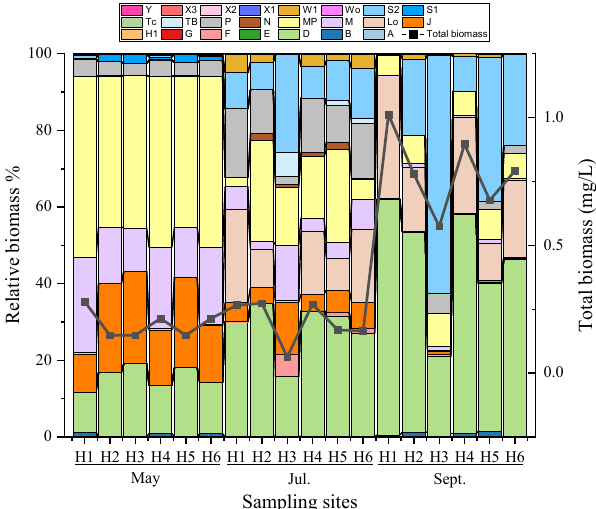
Figure 3. Seasonal variation of relative biomass and total biomass among functional groups of phytoplankton at six sampling sites (N1–N6) in Nanhai